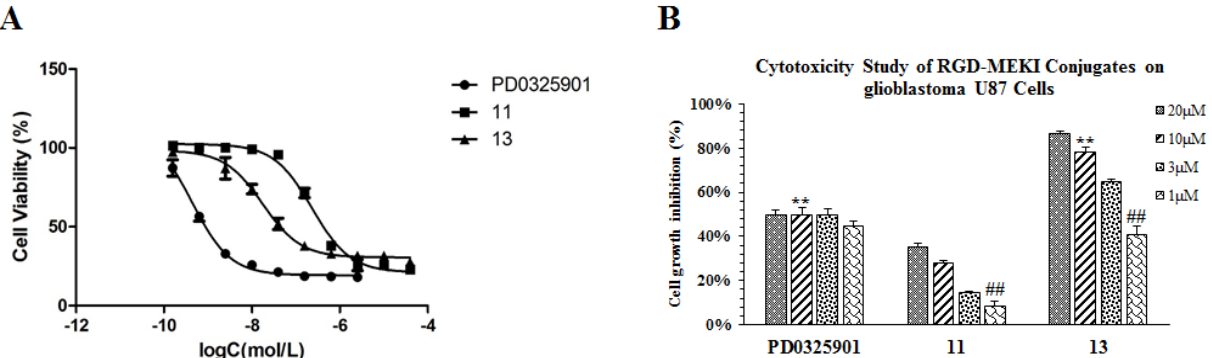
Figure 5. Cytotoxicity study of conjugate 13 , compared with parent drug (PD0325901) and MEKI ( 11 ) on both melanoma A375 ( A , IC 72h treatment by the SRB